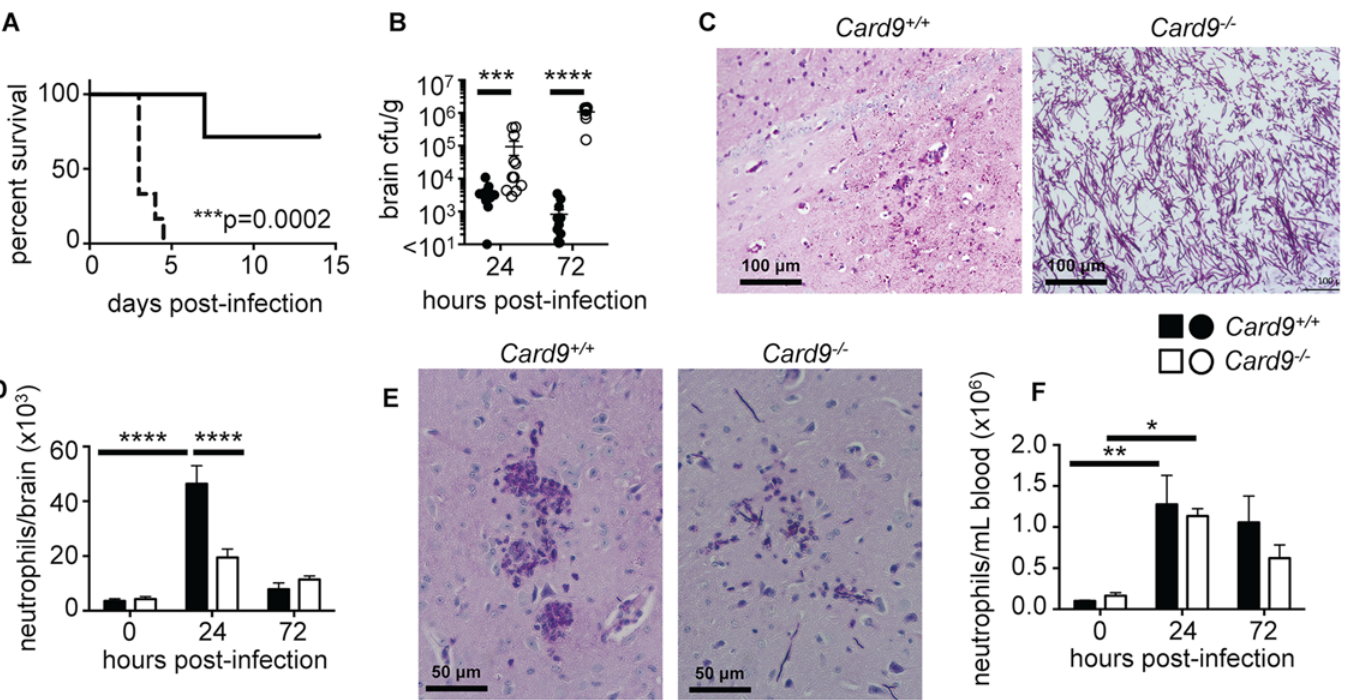
Fig 6. Card9 -/- mice are highly susceptible to candidiasis of the CNS and do not accumulate neutrophils into the infected brain. ( A ) WT (solid line, n = 7) and Card9 -/- (dotted line, n = 6) littermates were infected with 1x10 5 CFU SC5314 C . albicans SC5314 yeasts intravenously and survival monitored for 14 days post-infection; data analyzed by log-rank (Mantel-Cox) test. ( B ) Brains were isolated from WT (filled circles) and Card9 -/- (empty circles) mice at 24 (WT n = 12, KO n = 11) and 72 (WT n = 12, KO n = 10) hours post-infection and analyzed for fungal burden; data analyzed by Mann Whitney U-test. ( C ) PAS-stained brain sections from WT and Card9 -/- mice at 72 hours post-infection. Images were taken in the cerebrum region of the brain. Images are representative of 6 animals from 2 independent experiments. ( D ) Neutrophil numbers were determined by FACS in the brain of WT (filled bars, 0 hours n = 5, 24 hours n = 6 – 13, 72 hours n = 6 – 13) and Card9 -/- (empty bars, 0 hours n = 5 – 6, 24 hours n = 6 – 14, 72 hours n = 6 – 12) mice; data analyzed by two-way ANOVA. ( E ) PAS-stained brain sections from WT and Card9 -/- mice at 24 hours post-infection, analyzed as described in ( C ). ( F ) Neutrophil numbers in the peripheral blood, analyzed as in ( D ). In B-F, mice analyzed at 24 hours were infected with 1.3x10 5 CFU SC5314, and mice analyzed at 72 hours were infected with 7x10 4 CFU. All data is pooled from 2 – 4 independent experiments; data represent mean ± SEM. *** P < 0.005, **** P < 0.001.